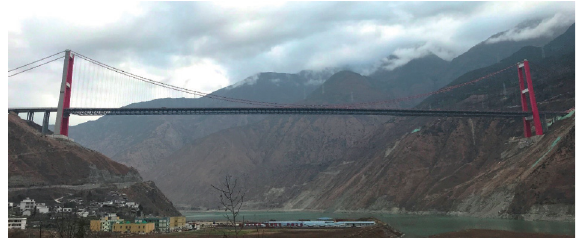
Figure 1: View of the Dadu river Xingkang bridge.